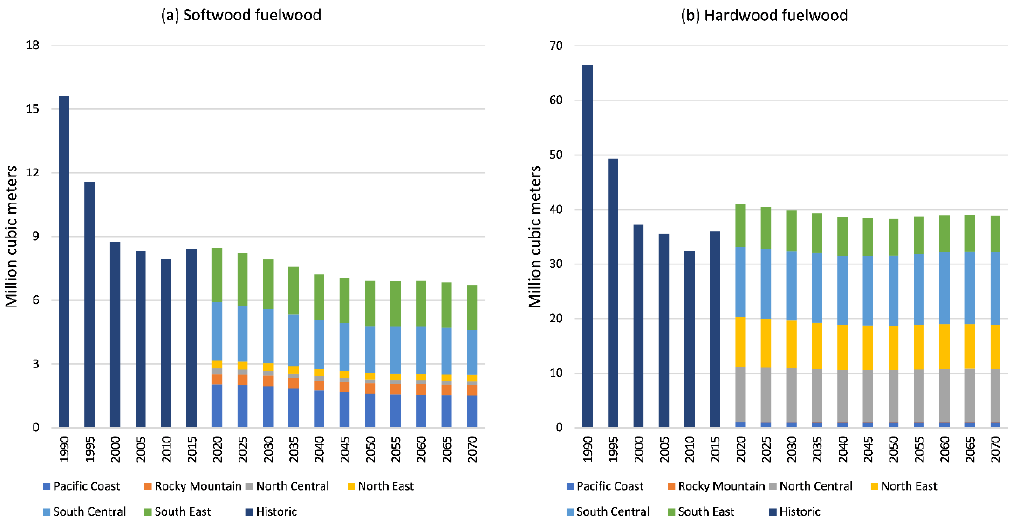
Figure 13. United States production of fuelwood by ( a ) softwood and ( b ) hardwood species groups, within SSP2, 1990 to 2015 historic, 2020 to 2070 projections from FOROM.